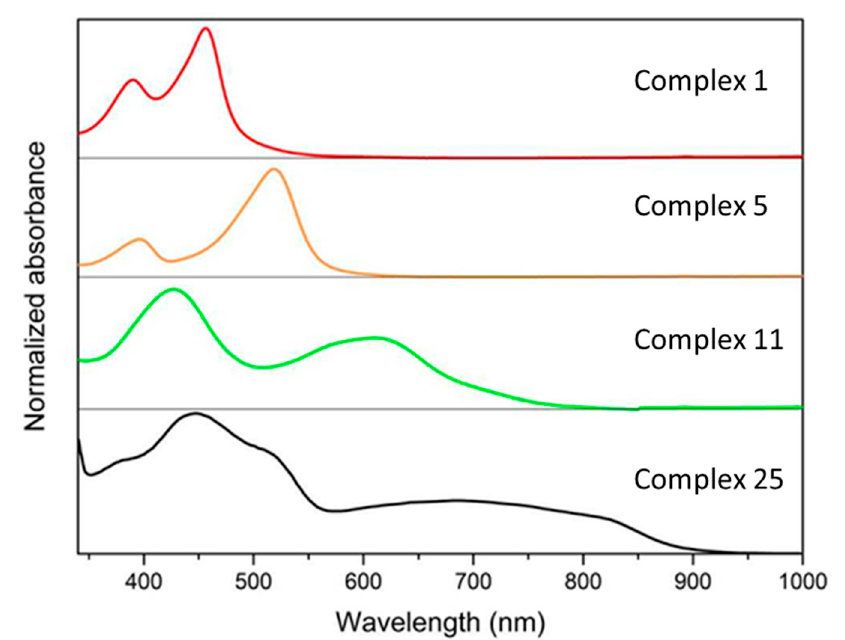
Figure 5. Steady-state absorption spectra of Fe(II) complexes 1 , 5 , 11 , and 25 in dry acetonitrile, illustrating a gradual extension of the low energy absorption bands towards the red part of the visible spectrum with different carbene modifications discussed in the text. All spectra are normalized and vertically offset for clarity.